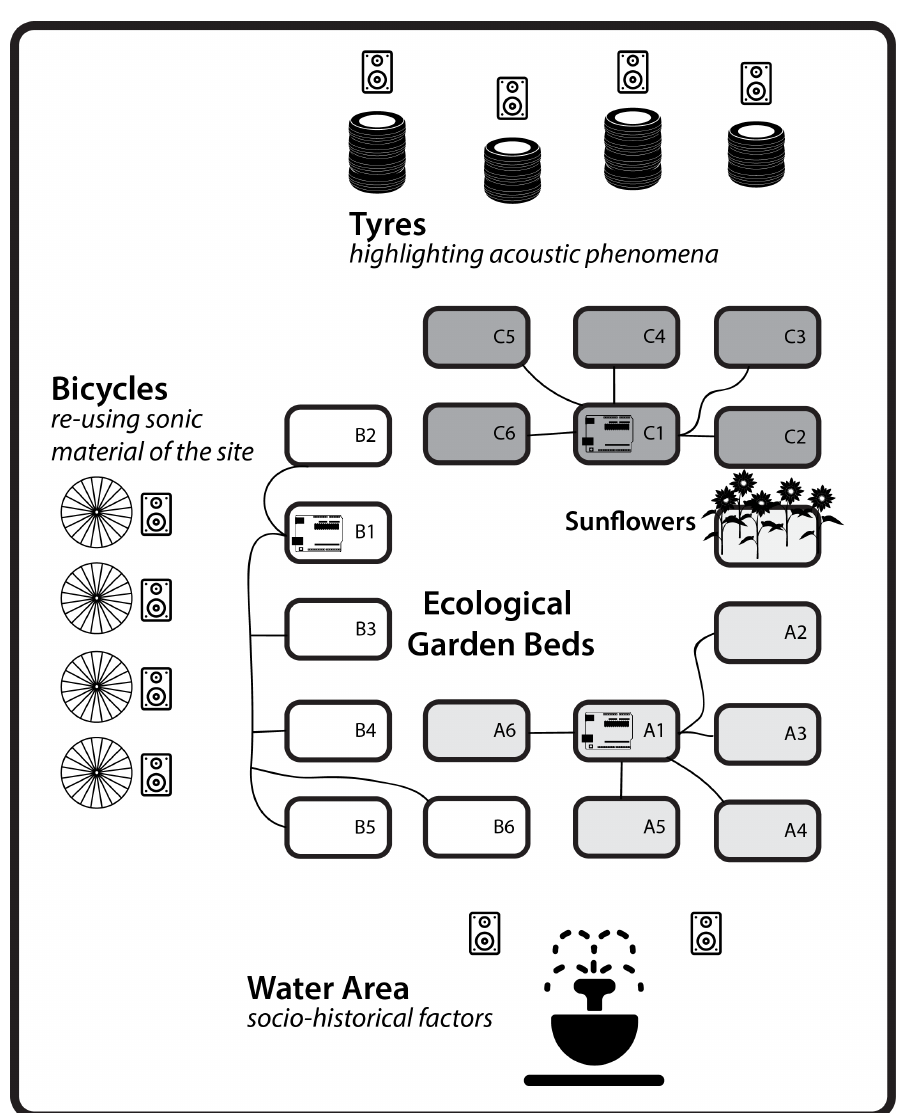
Figure 5. Layout of installations, Clark Park Community Garden, Tempe,